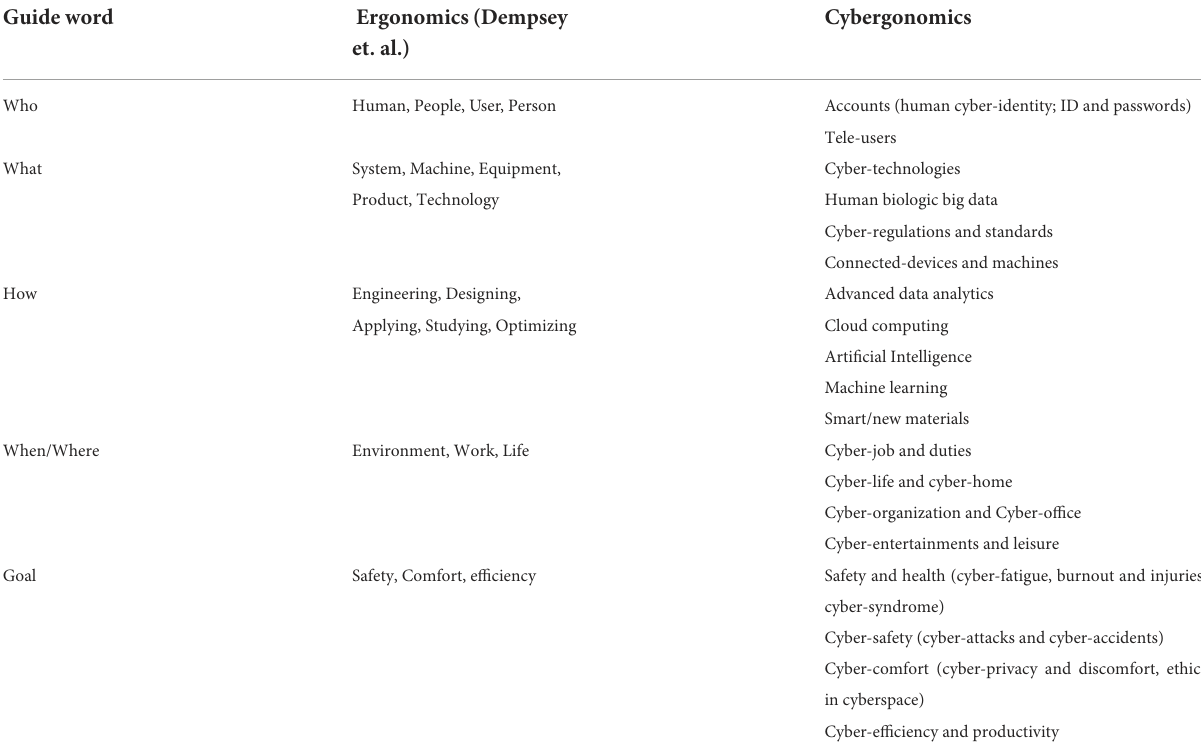
TABLE 1 Definition elements of cybergonomics based on six guide word